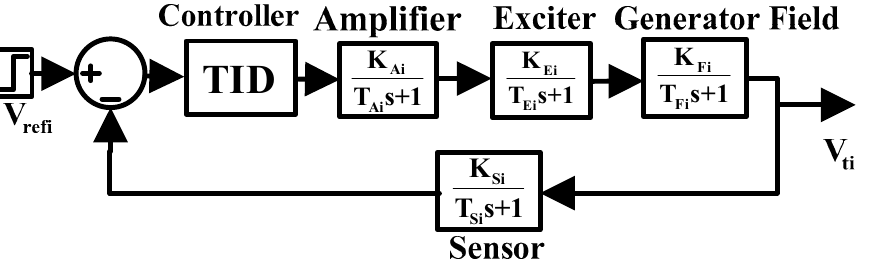
Figure 4. The second test system, AVR.